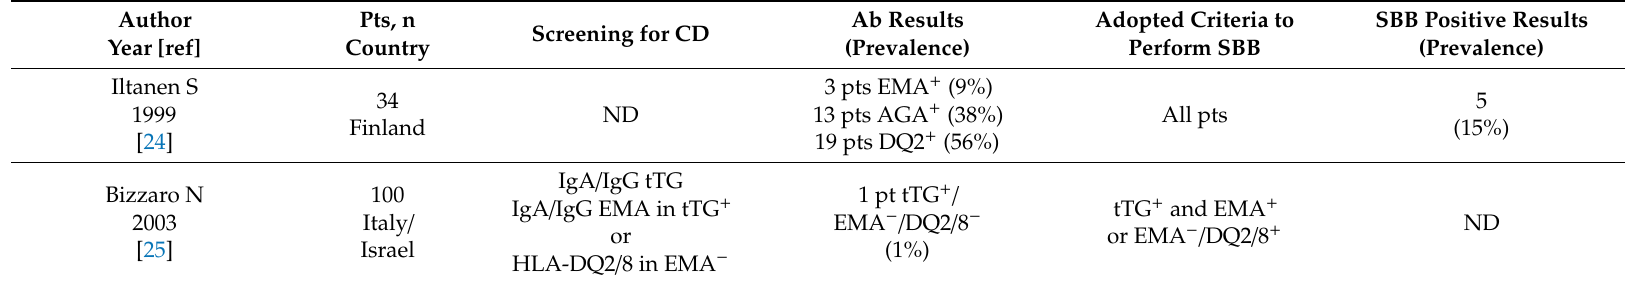
Table 2. Celiac disease prevalence in Sjögren’s